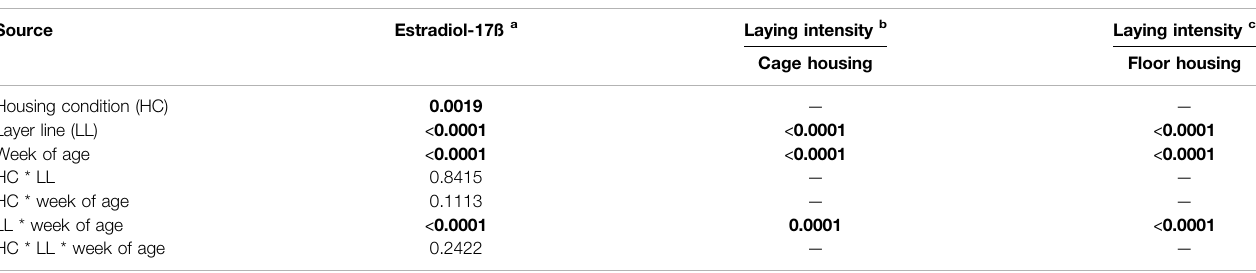
TABLE 1 | Signi fi cance of fi xed effects ( p